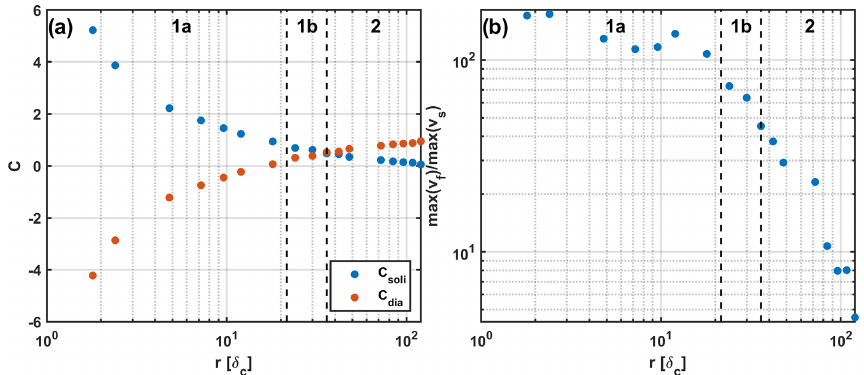
Figure 6. Quantitative parameters as function of initial perturbation radius in terms of compaction length. (a) Solitary wave (blue) and diapir (red) partition coefficients for several initial perturbation radii. (b) Ratio of maximum fluid velocity to maximum absolute solid velocity in the entire